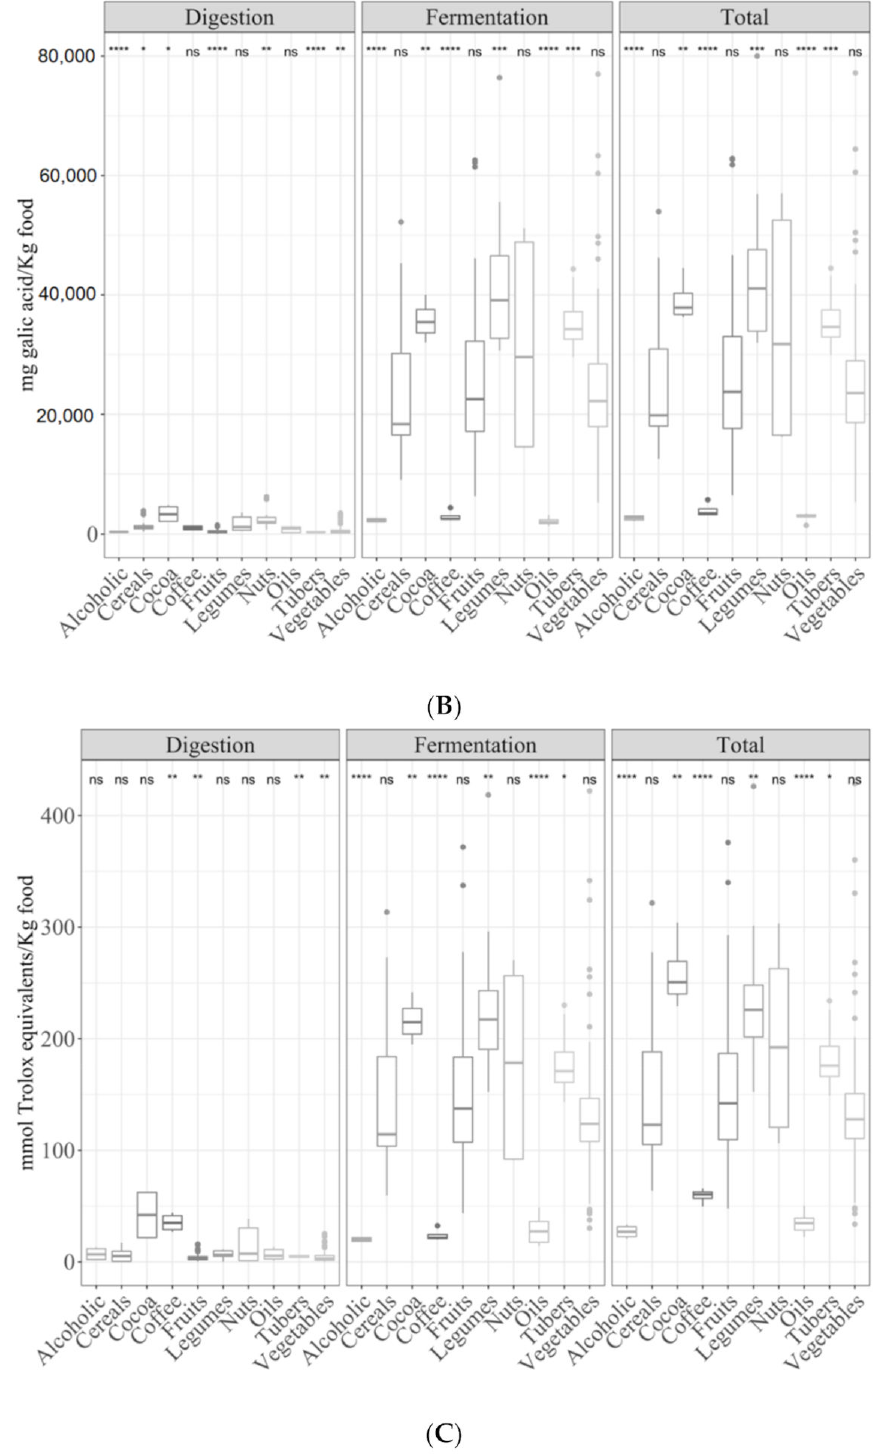
Figure 3. Antioxidant capacity of plant foods (obtained after in vitro digestion and fermentation) depending on the food group (( A ) TEAC DPPH , ( B ) Folin–Ciocalteu and ( C ) TEAC FRAP ). Statistical analysis was performed via ANOVA using the mean antioxidant capacity of all food groups as the reference group. Statistic labels: *: p < 0.05, **: p < 0.01, ***: p < 0.001, ****: p < 0.0001, ns: not